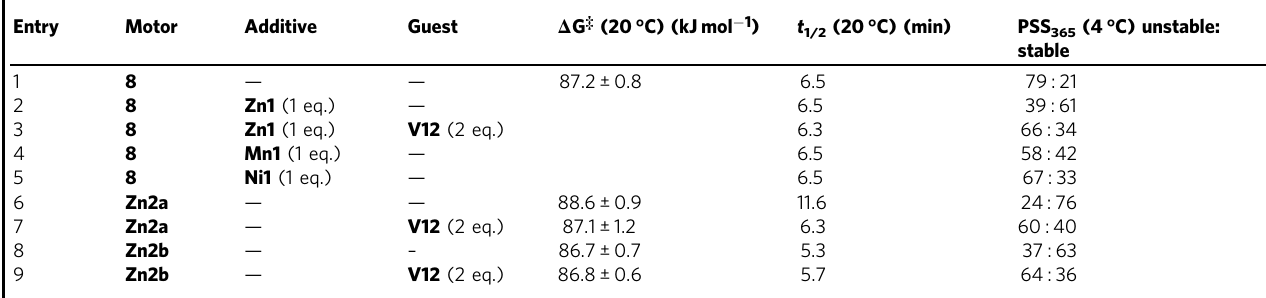
Table 1 Photochemical and thermal properties of motor